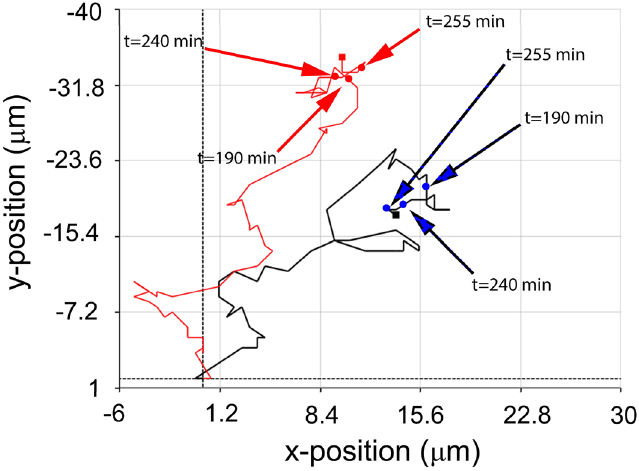
Figure 5. Tracking and movement of the invasive (black) and non-invasive (red) HeLa cells presented in Fig. 4. Each graph presents the cells’ position at a specified time elapsed since seeding: 190 min, 240 min, 255 min, and 270 min. The invasive cell circles around a possible spot optimal for infiltration of the underlying Vero